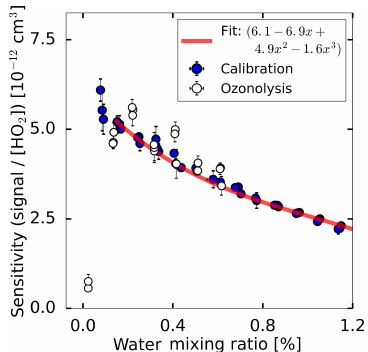
Figure 3. Measured HO 2 sensitivity as a function of the water mix- ing ratio in two experiments. For the calibration, HO 2 was produced by the radical source while varying the water-vapour concentration which causes a change in the HO 2 radical concentration. During the ozonolysis experiment, HO 2 was produced from the ozonolysis of 2,3-dimethyl-2-butene, which is independent of the water vapour mixing ratio. The red line shows a third-order polynomial fit applied to the calibration data for the range of water vapour mixing ratios higher than